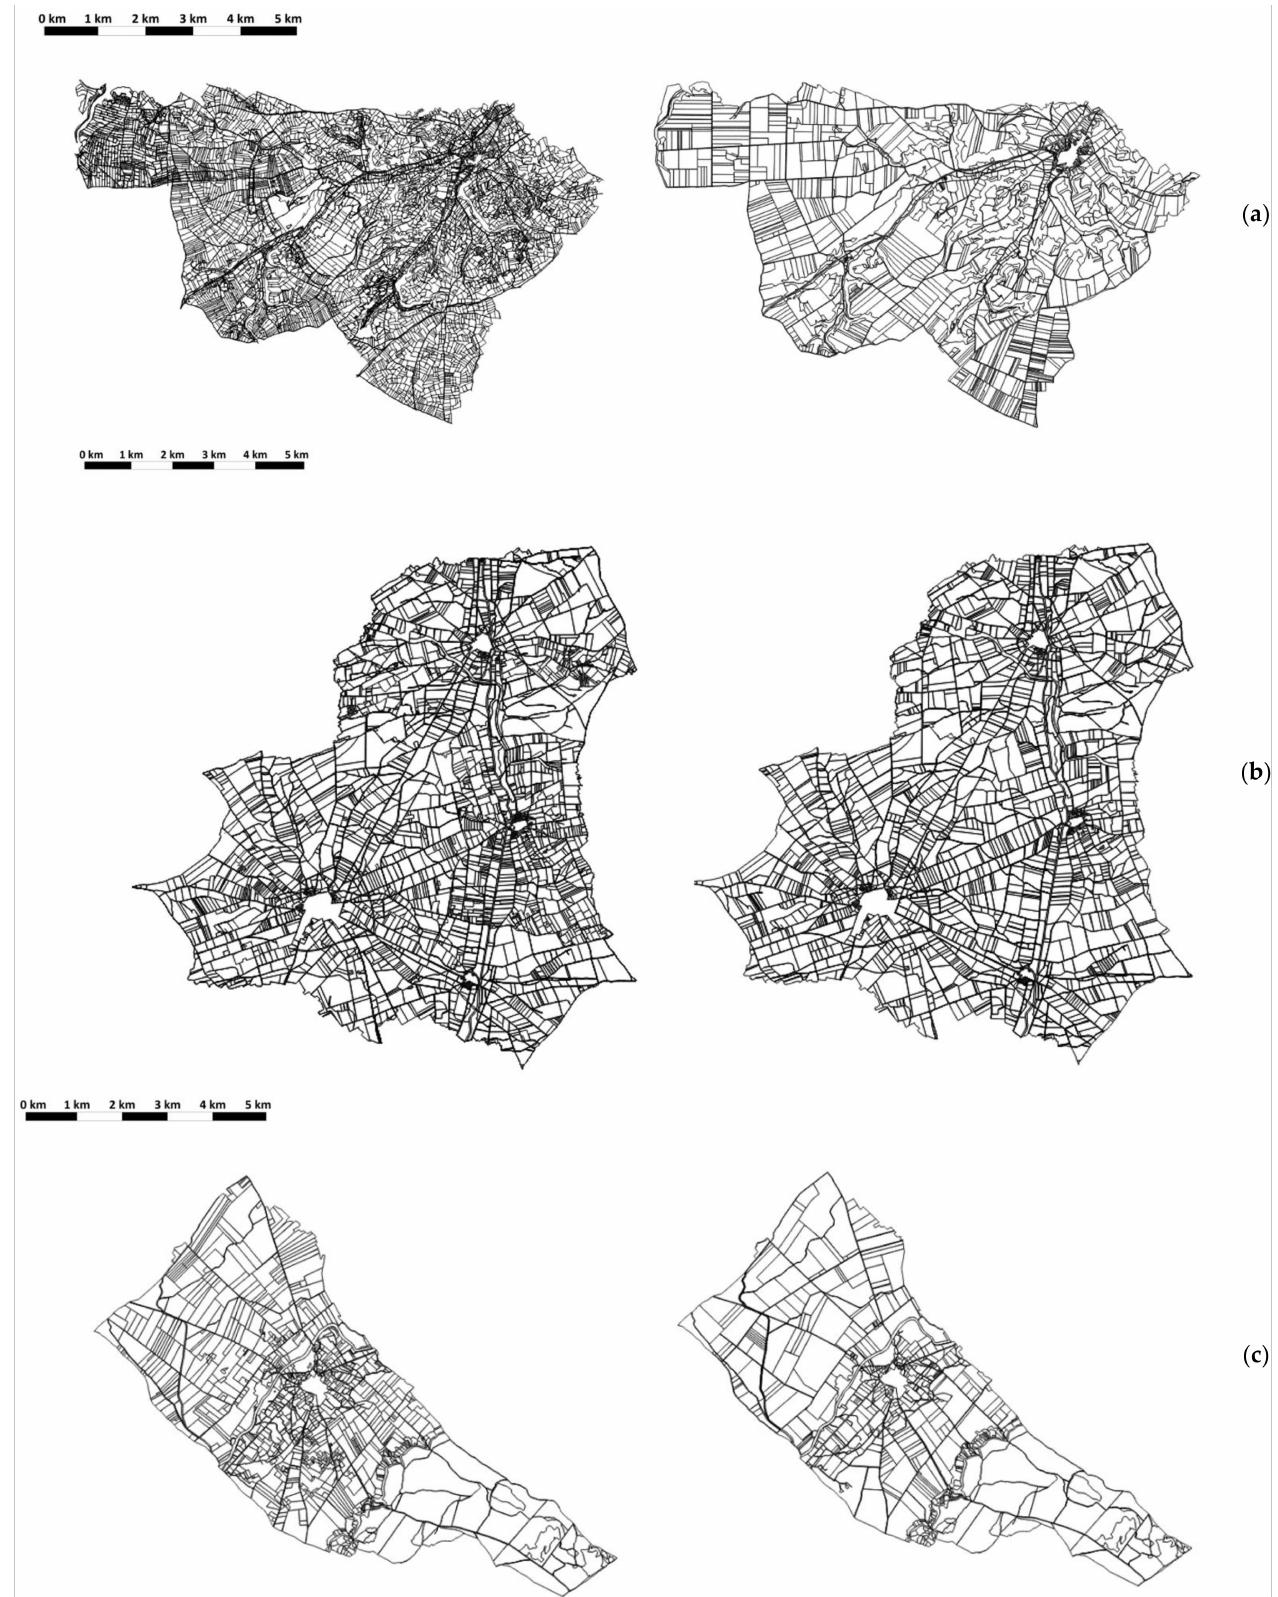
Figure 2. Pre and post LC layout of the plots in SA1 ( a ), SA2 ( b ), and SA3 ( c